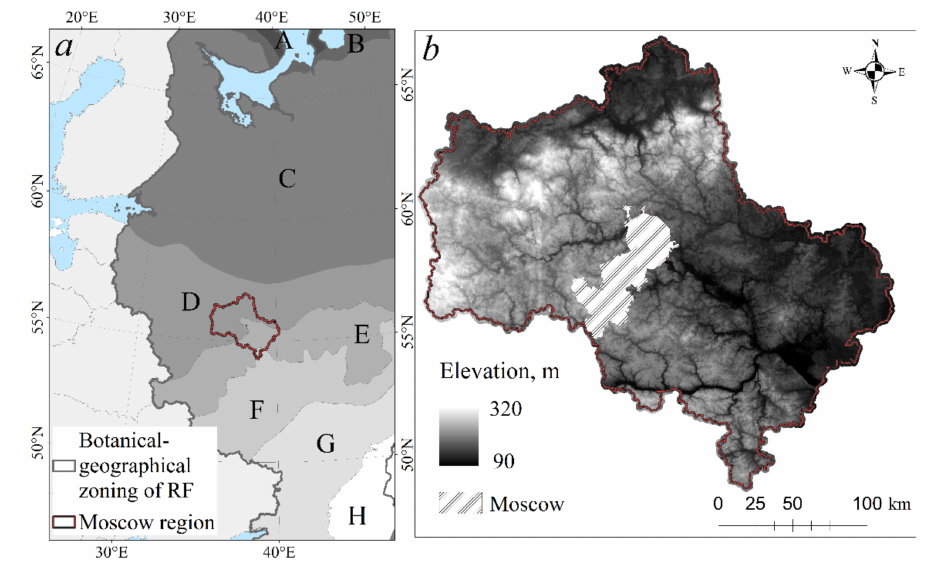
Figure 1. The study area: ( a ) Vegetation zones acc. to (Kurnaev, 1973 [45]): A—tundra; B—forest-tundra; C—coniferous forests; D—coniferous–broad-leaved forests; E—broad-leaved forests; F—forest-steppe; G—steppe; H—semi-desert; ( b ) DEM of the Moscow